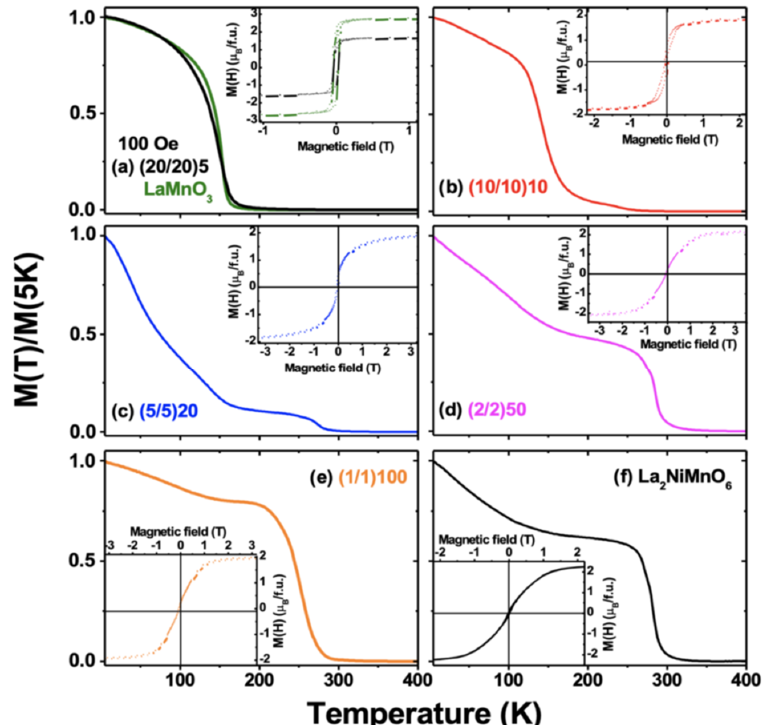
Figure 5. Temperature, M(T), and magnetic field, M(H), (inset at H = 100 Oe) dependences of magnetization ( a ) of the LaMnO 3 film (green) with thickness at d LMO = 16 nm, and of the nLMO/nLNO (n/n) SLs (20/20, black); ( b ) (10/10, red); ( c ) (5/5, blue); ( d ) (2/2, magenta); ( e ) (1/1, orange); and ( f ) (SoA, black) grown by MAD technique. Adopted with permission from American Physical Society (Copyright 2021) ref. [9].